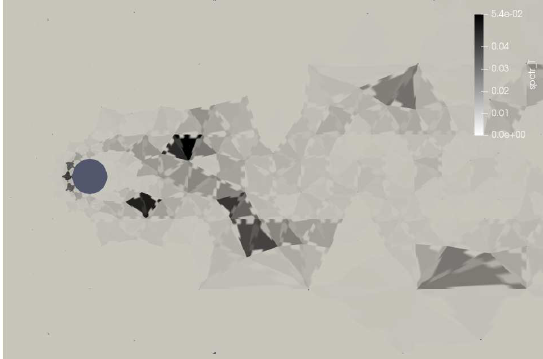
Fig. 5. Distribution of spatial error over the computational mesh. Values obtained as a sum of spectral coe ffi cients belonging to highest degree boundary modes. Max value ≈ 5 × 10 − 2